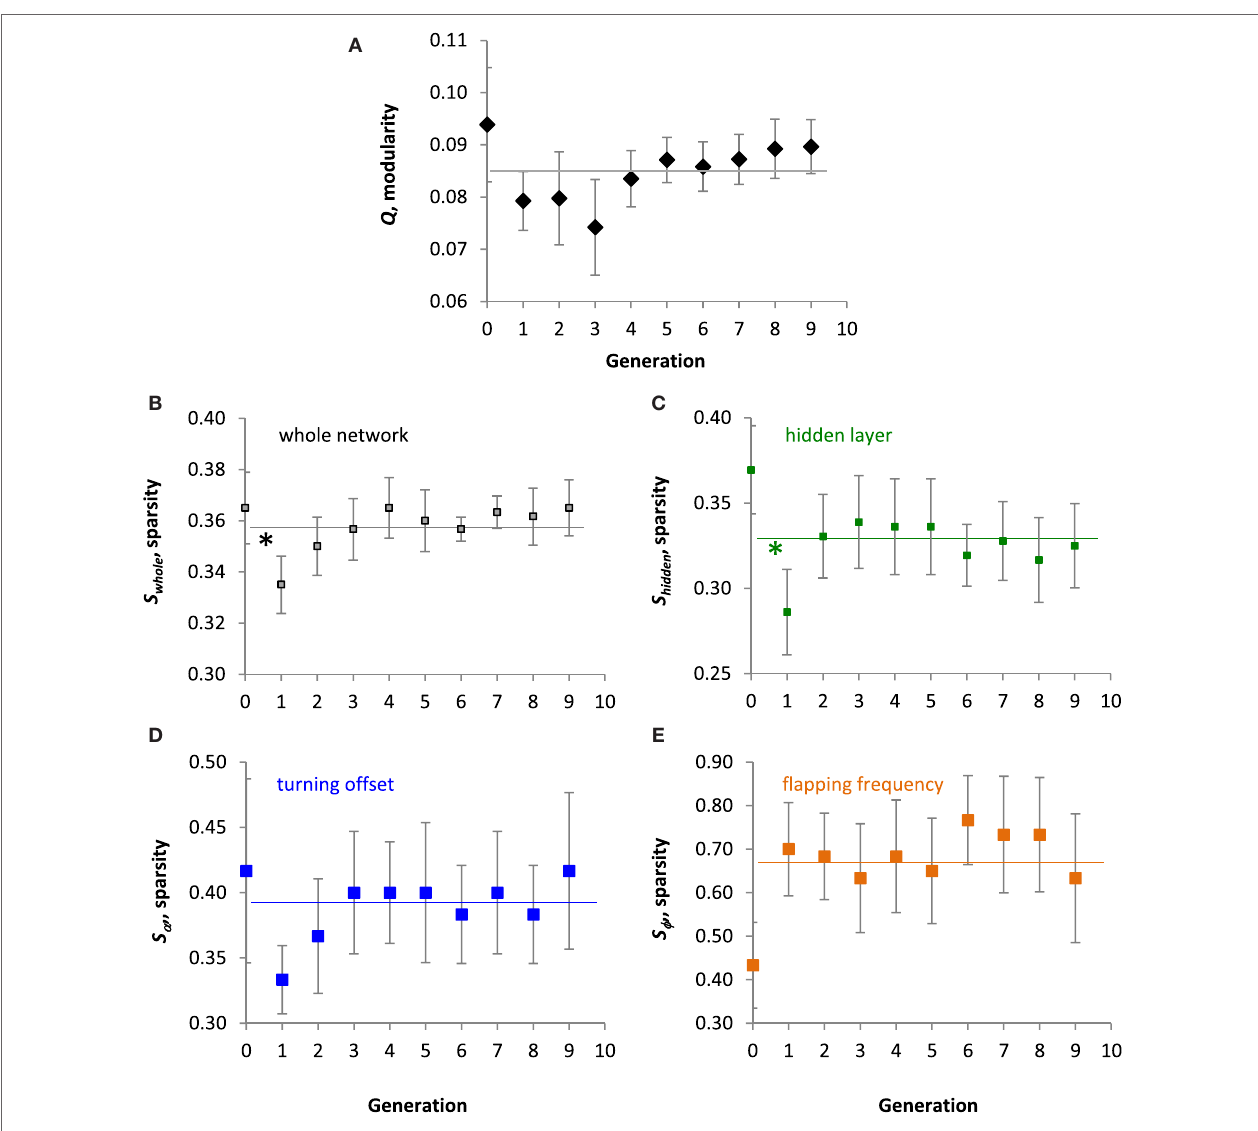
FigUre 7 | evolution of the anns . All values are means ( N = 10) of the population ± SE. (a) Modularity, Q . No significant linear trend was detected over 10 generations. The grand mean of 0.085 is indicated by the horizontal line. (B–e) Sparsity of the whole ANN, the hidden layer, projections of the hidden layer to the turning offset, and projections of the hidden layer to flapping frequency output, respectively. No significant linear trends were detected over 10 generations. Grand means of 0.358, 0.329, 0.390, and 0.665, respectively, are indicated by the horizontal lines. For both the whole network and the hidden layer, a priori contrasts showed a significant decrease in the mean values between generations 0 and 1 (* p <